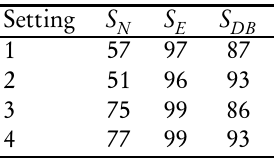
Percentage of S statistics lower than 1.1 under M